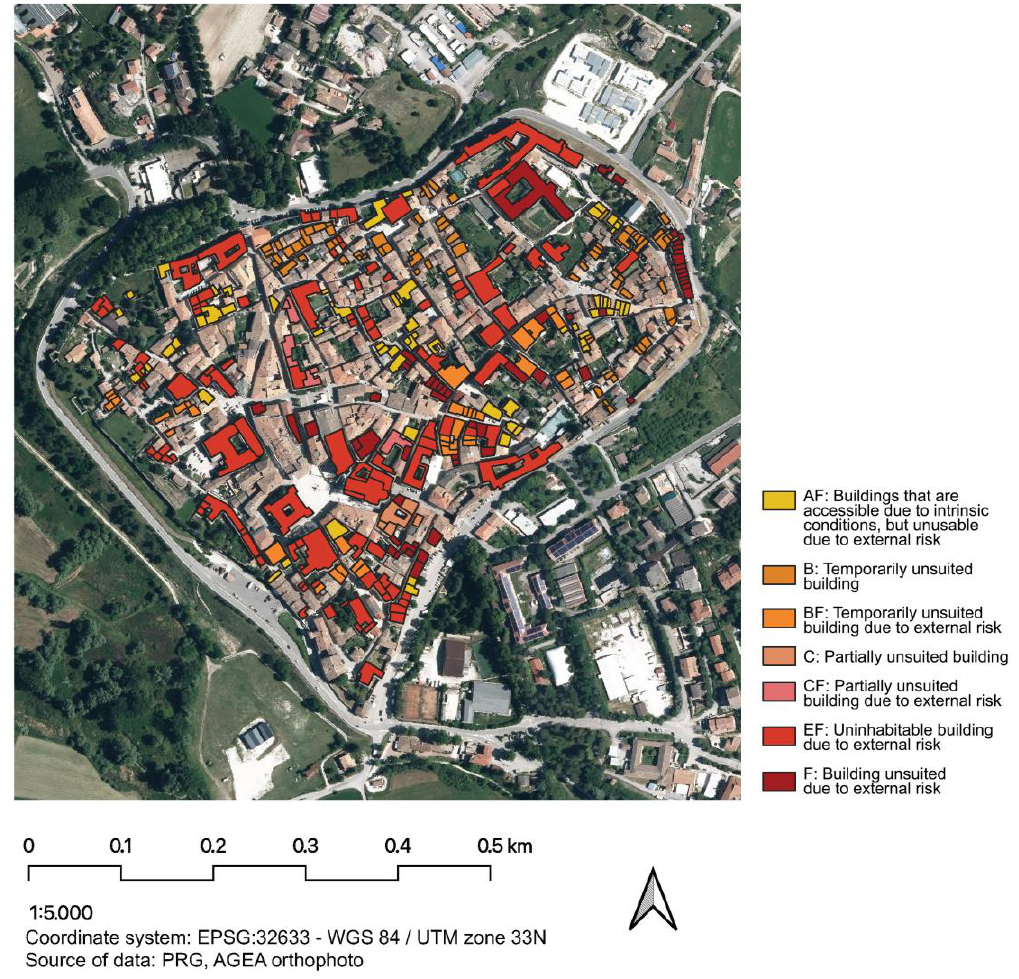
Figure 6. Ortophoto with cadastral polygons of the Norcia urban centre, encoded by Level of usability due to seismic damage (AeDES reports).